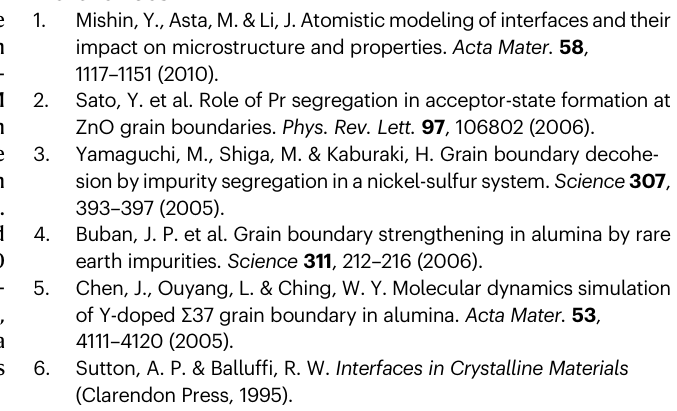
Si dopants are located at A and D sites in the M(Al) GB structure, respec- tively. The black vertical lines correspond to the Fermi levels at respective thermal